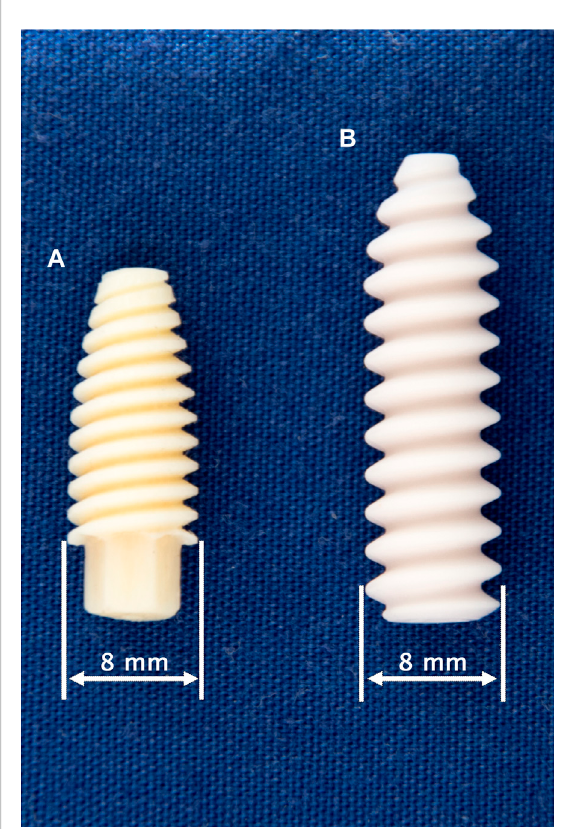
FIGURE 1 Tested fi xation screws: 8 × 21 mm Shark Screw ACL (surgebright GmbH, Lichtenberg bei Linz, Austria) (A) and 8 × 28 mmBioCompositeInterferenceScrew(ArthrexInc.,Naples,FL, United States) (B)